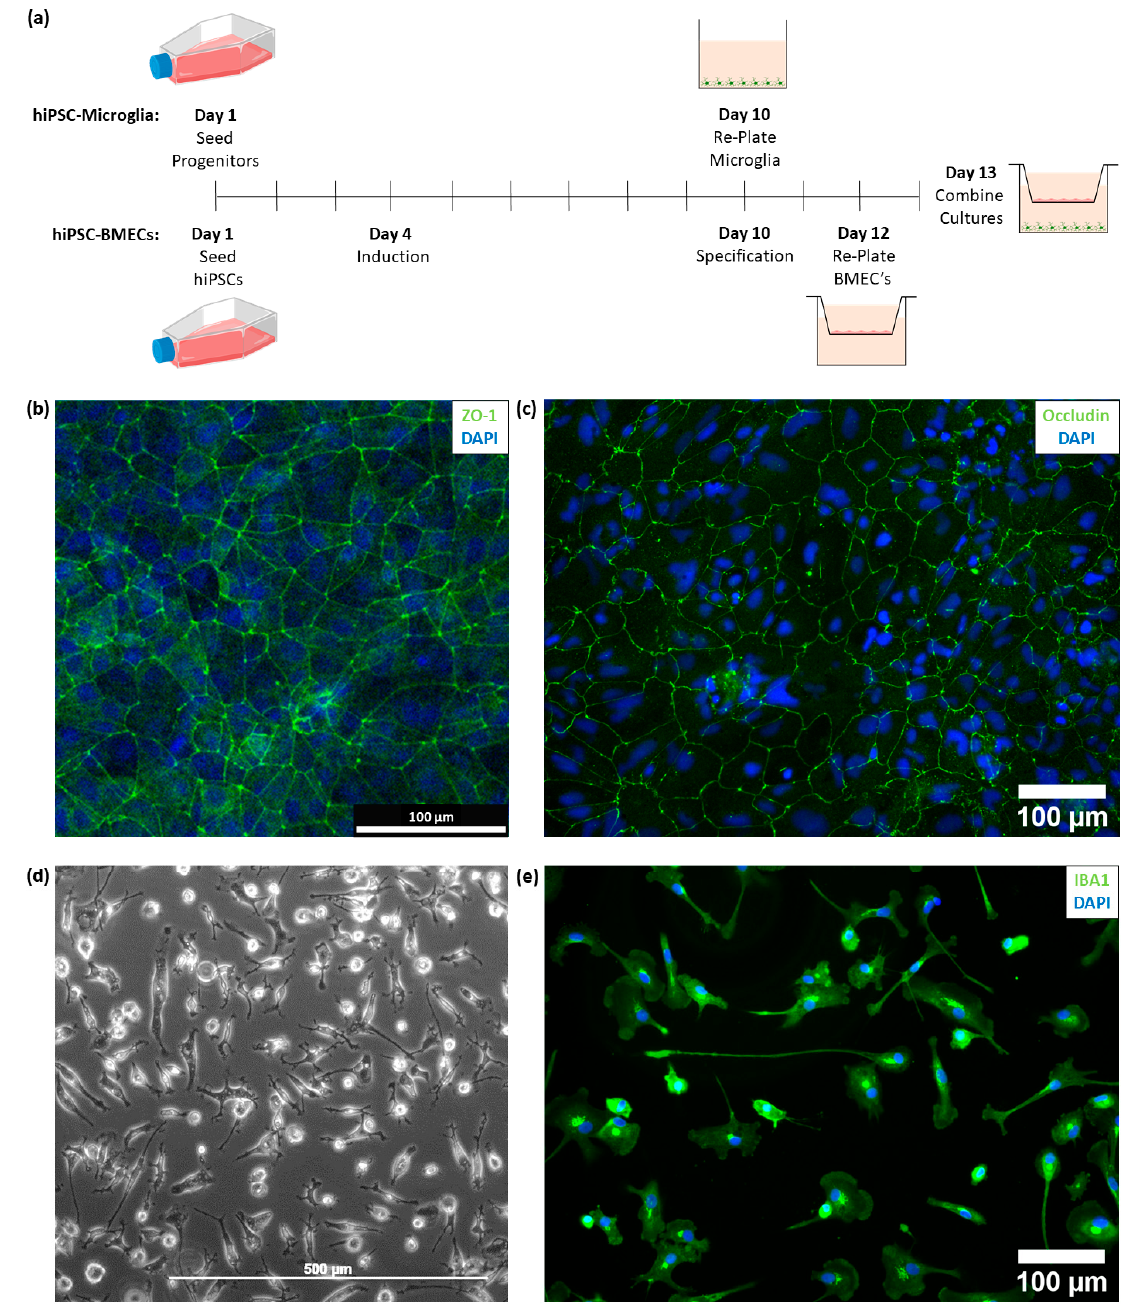
Figure 1. ( a ) Timeline for the differentiation of the human inducible pluripotent stem cell (hiPSC)-derived brain microvascular endothelial cells (BMECs) (pink, in the transwell insert) and hiPSC-derived microglia (green, at the bottom of the plate) cultures, as well as when to combine the cultures to generate the transwell co-culture system. Images were created with BioRender.com. ( b ) Immunofluorescence image of hiPSC-derived BMECs with zonula occludens-1 (ZO-1, green) and 4 ′ ,6-Diamidino-2-Phenylindole (DAPI, blue) staining. ( c ) Immunofluorescence image of hiPSC-derived BMECs with occludin (green) and DAPI (blue) staining. ( d ) Bright field image of the hiPSC-derived microglia cells during differentiation. ( e ) Immunofluorescence image of hiPSC-derived microglia with ionized calcium-binding adaptor molecule 1 (IBA1, green) and DAPI (blue) staining.